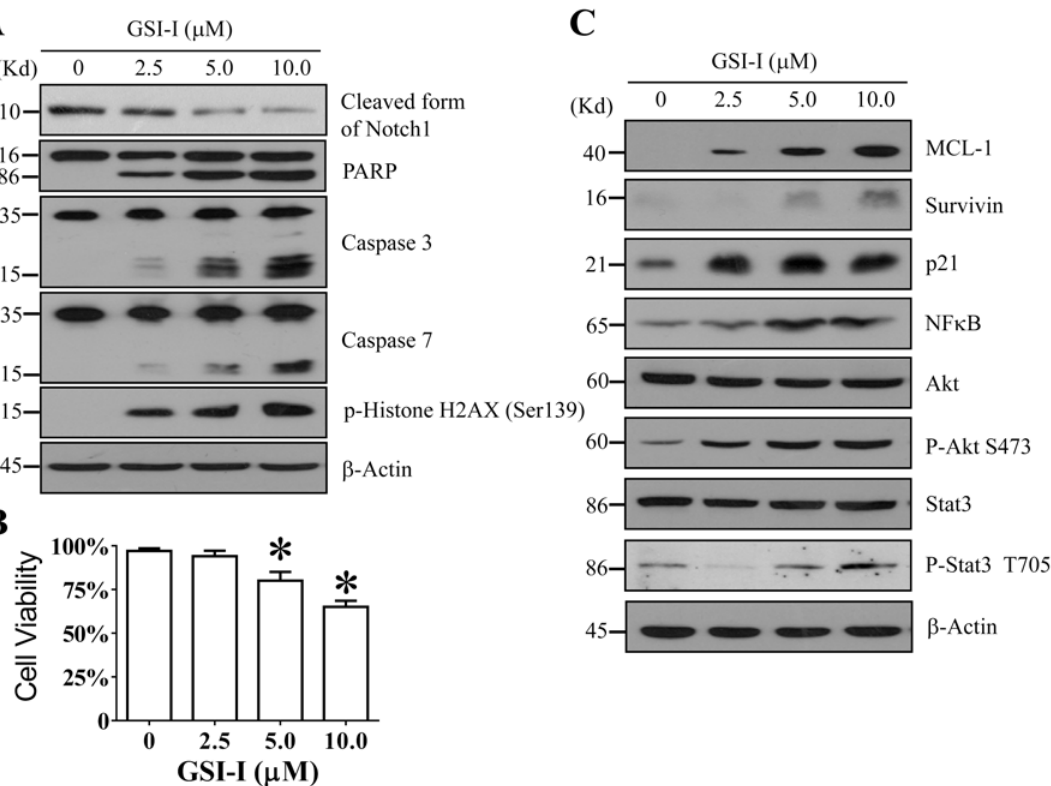
Fig 1. The GSI-I treatment induces a caspase-dependent apoptosis in hUC-MSCs at 24 h after treatment. A. Western blotting shows that the treatment reduces the cleaved Notch1, induces cleavage of caspases 3 and 7, PARP proteins, and increases p-Histone H2AX. B. WST-8 cell viability assay shows that the treatment significantly reduces viability of hUC-MSCs. The * indicates statistical significance with p < 0.05. C. Western blotting shows that the treatment elevates Mcl-1, p21, Survivin, NFkB, p-Akt and